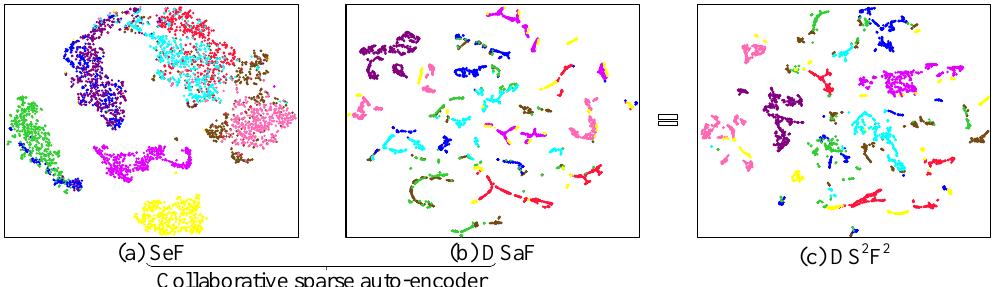
Figure 1. Visualization of features before and after collaborative fusion by t-SNE [33]: ( a ) raw spectral feature (SeF) ( b ) deep spatial feature (DSaF), and ( c ) deep spectral–spatial fusion feature (DS 2 F 2 ). Take the University of Pavia dataset as